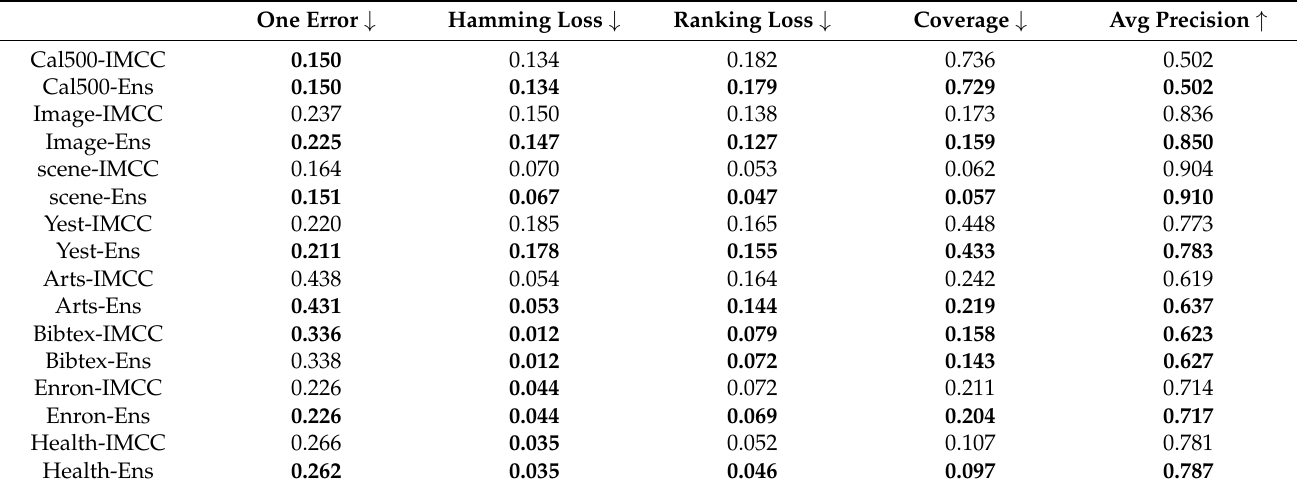
Table 6. Comparison of IMCC and our proposed ensemble ENS using five performance indicators. Bold highlights superior performance.